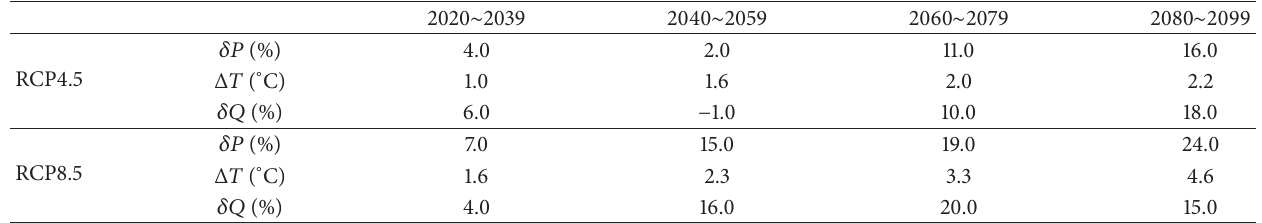
Table 3: RCM projected precipitation change ( 𝛿𝑃 ), temperature change ( Δ𝑇 ), and streamflow change ( 𝛿𝑄 ) for the 21st century under RCP4.5 and RCP8.5 compared to the control period (1986 ∼